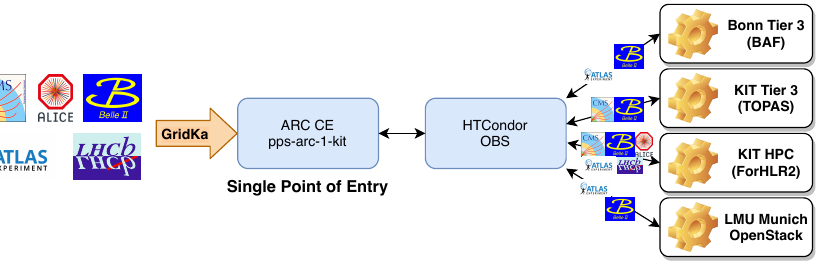
Figure 1. Multi-experiment setup to allow for a dynamic and transparent integration of opportunistic resources into WLCG computing at the German Tier-1 centre GridKa at